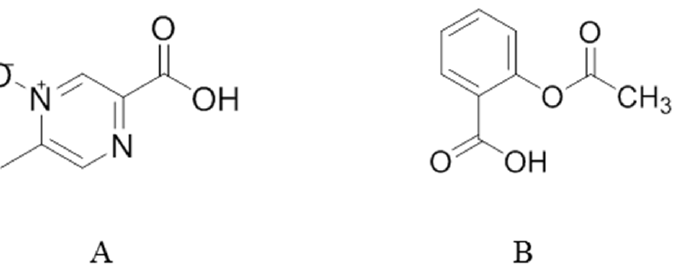
Figure 1. Chemical structures of the analytes: acipimox ( A ) and the internal standard (IS) acetylsalicylic acid ( B ).